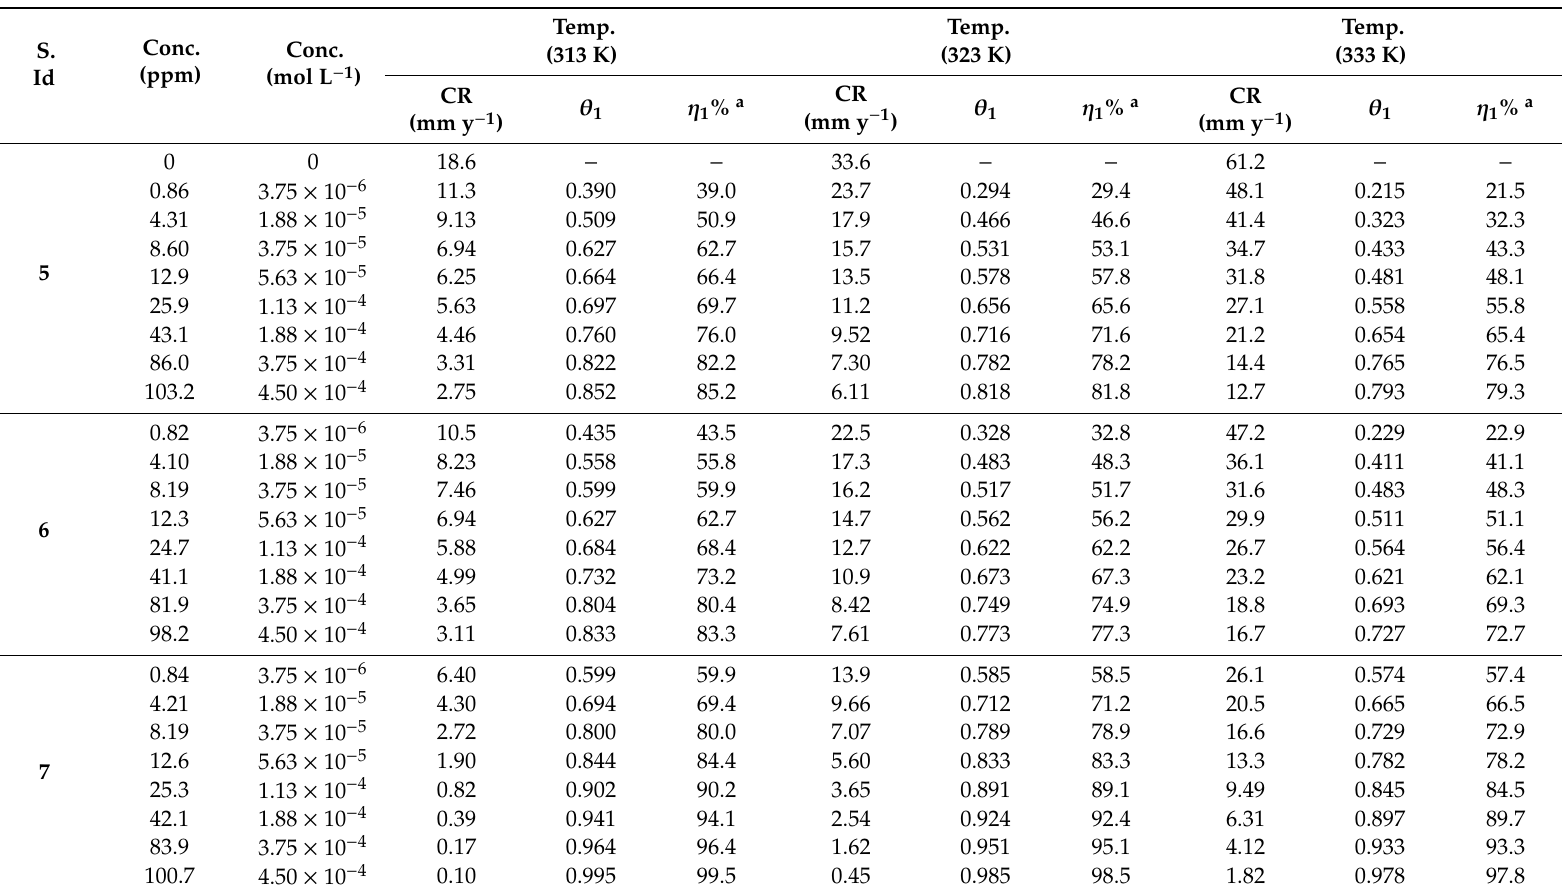
Table 2. Di ff erent corrosion parameters: corrosion rate ( CR ), surface coverage ( θ 1 ), and inhibition e ffi ciency ( η 1 %) of mild steel in 1 M HCl solution without and with corrosion inhibitors 5 – 7 at di ff erent temperatures (313–333 K), obtained from weight loss